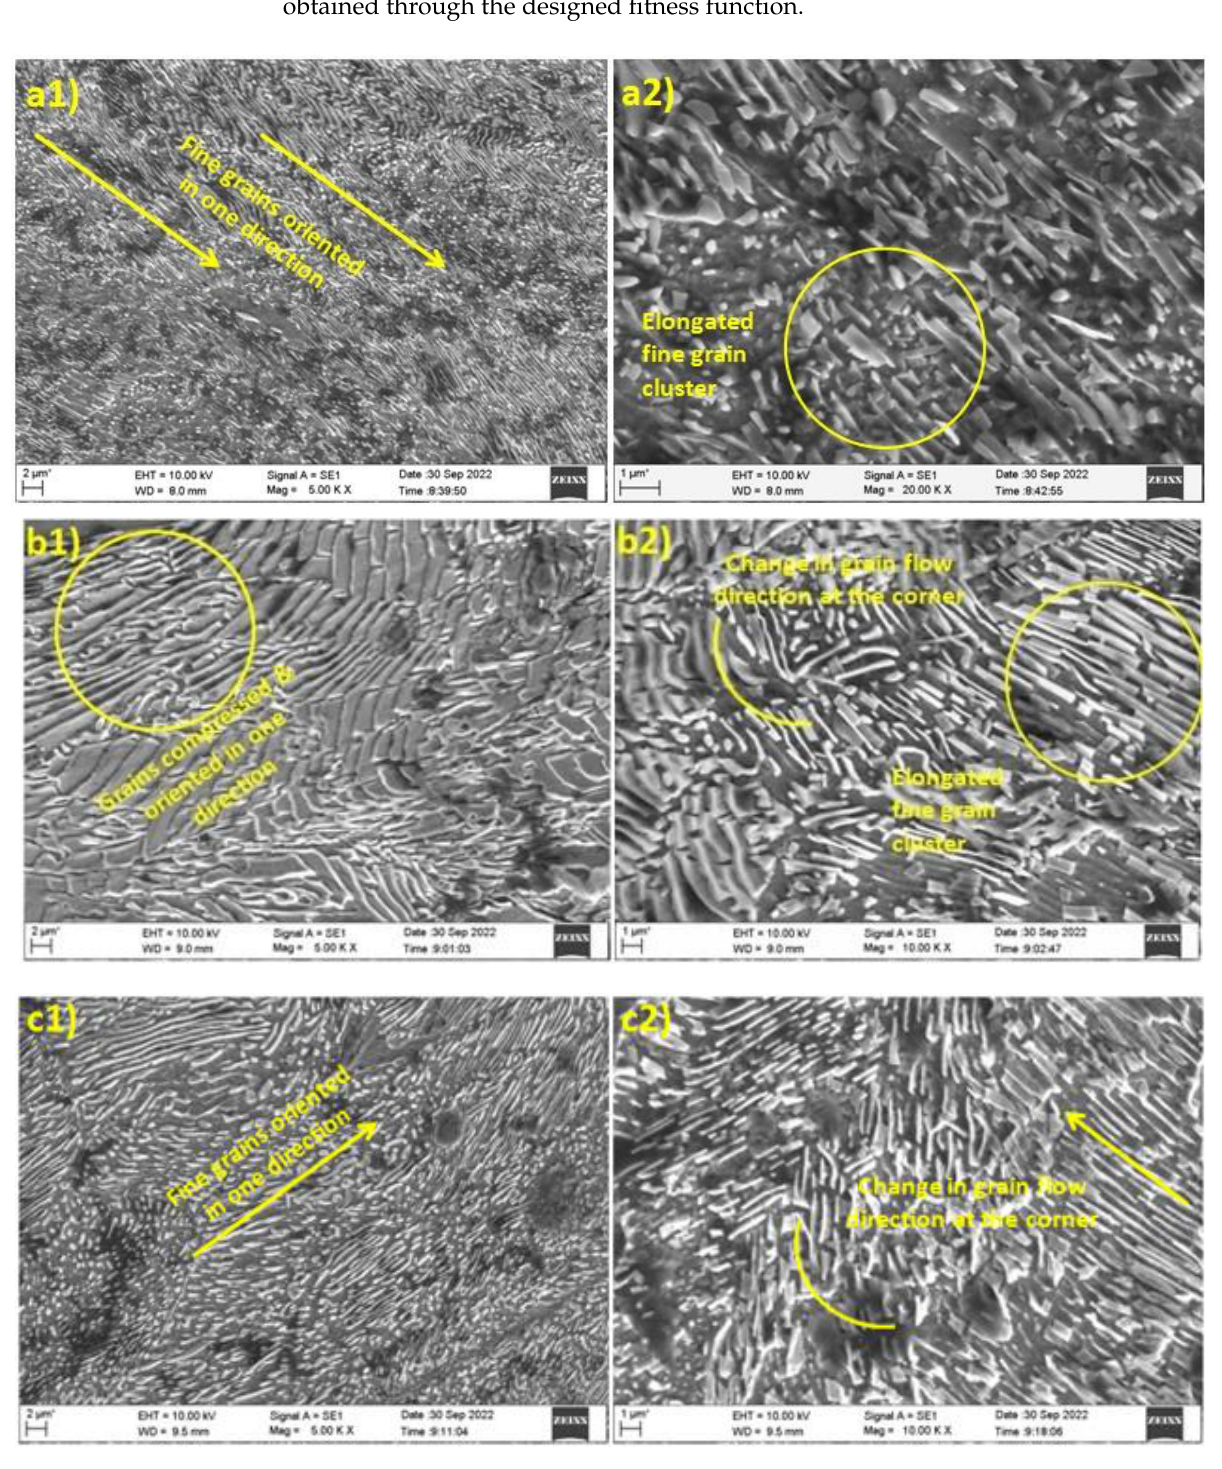
Figure 24. Microstructure of AISI steels. ( a1 , a2 ) AISI 1010; ( b1 , b2 ) AISI 1018; ( c1 , c2 ) AISI 1045.